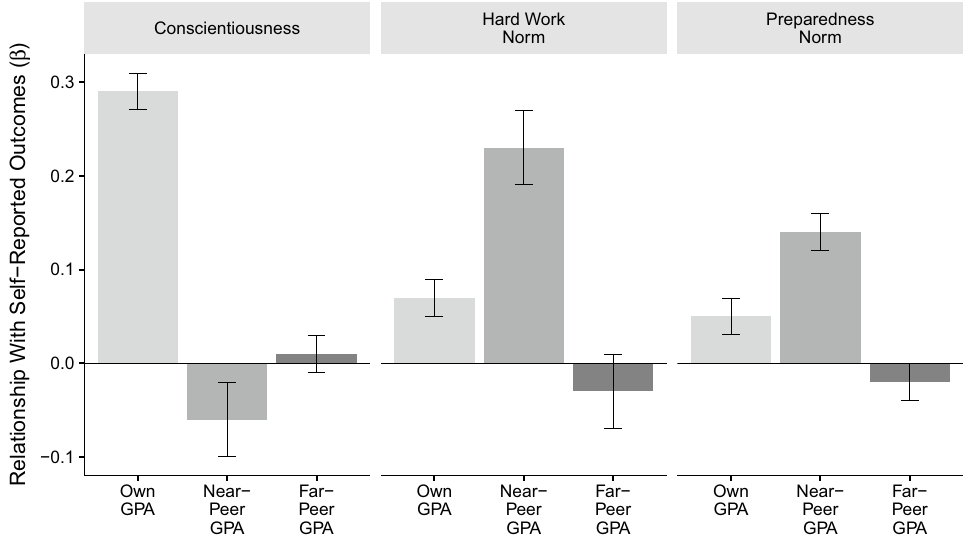
Figure 3. In Study 2, self-reported conscientiousness correlated positively with a student’s own GPA and negatively with the GPA of near-peers. In contrast, standards for what constitutes hard work and preparedness correlated positively with both own and near-peer GPA. As expected, there was no effect of far-peer GPA. OLS models included demographic controls and school fixed effects. Error bars represent 95% confidence intervals. Model R 2 s for conscientiousness, hard work norms, and preparedness norms were 0.095, 0.159, and 0.059,